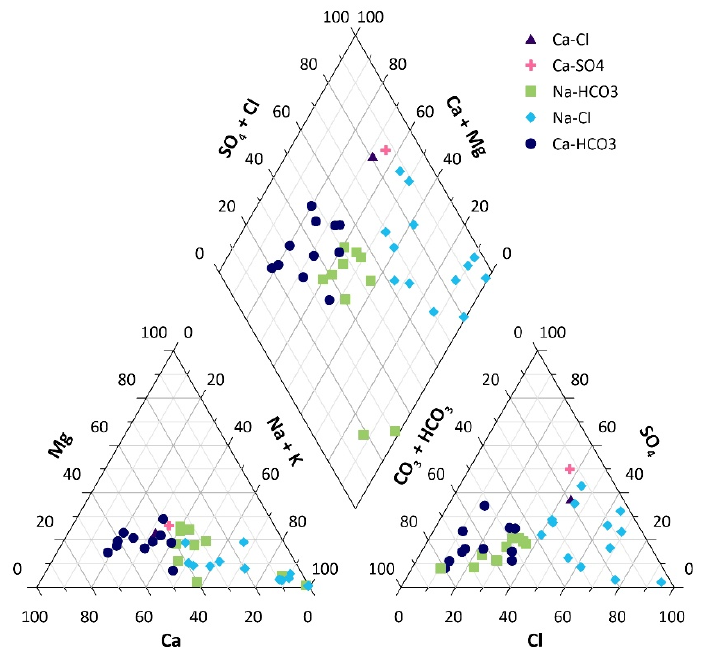
Figure 2. Piper diagram showing the hydrochemical facies of the waters from the study area afterward [19,20].